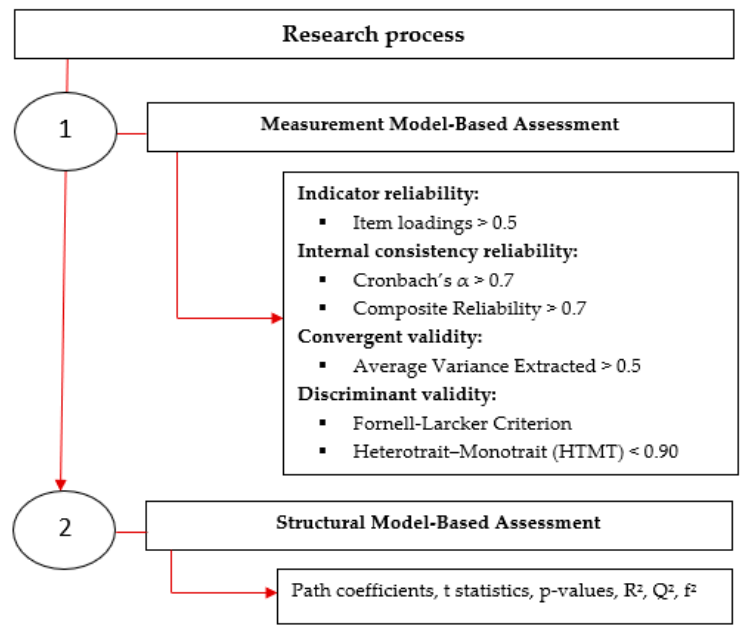
Figure 2. The research process. Source: own work.